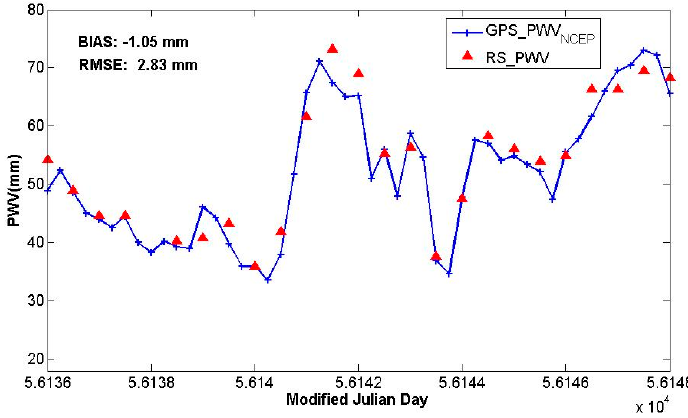
Figure 14. Time series of GPS_PWV NCEP from 00:00 on 28 July to 24:00 on 8 August 2012 at SHAO station.